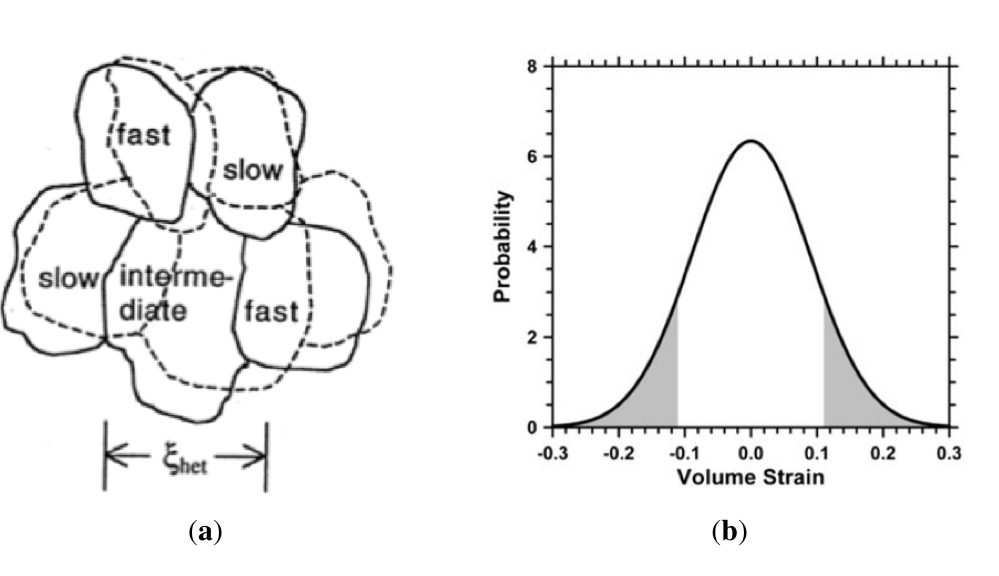
Figure 9. Dynamic inhomogeneities in density according to Ediger [56], and distribution of volumetric strain in random clusters according to Egami